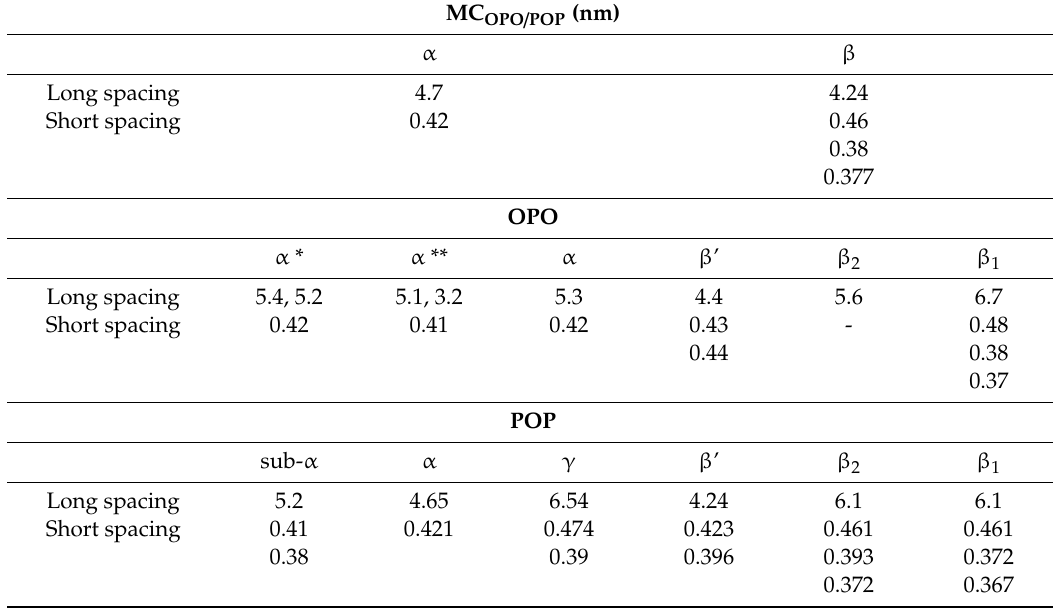
Table 1. Long and short spacing values of molecular compound (MC) OPO / POP , 1,3-dioleoyl-2-palmitoyl- sn -glycerol (OPO), and 1,3-dipalmitoyl-2-oleoyl- sn -glycerol (POP). MC OPO / POP (nm) α β Long spacing 4.7 4.24 Short spacing 0.42 0.46 0.38 0.377 OPO α * α ** α β ’ β β 2 1 Long spacing 5.4, 5.2 5.1, 3.2 5.3 4.4 5.6 6.7 Short spacing 0.42 0.41 0.42 0.43 0.48 0.44 0.38 0.37 POP sub- α α γ β ’ β 2 β 1 Long spacing 5.2 4.65 6.54 4.24 6.1 6.1 Short spacing 0.41 0.421 0.474